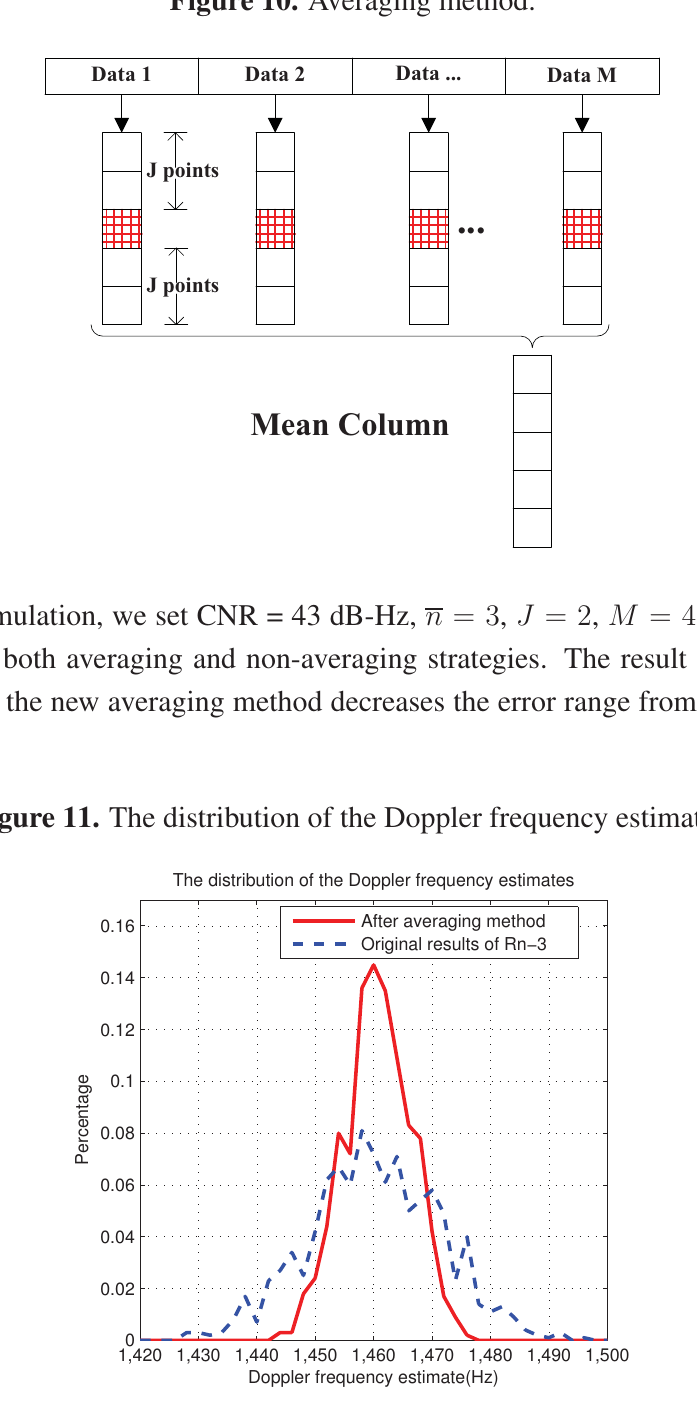
Figure 10. Averaging method.